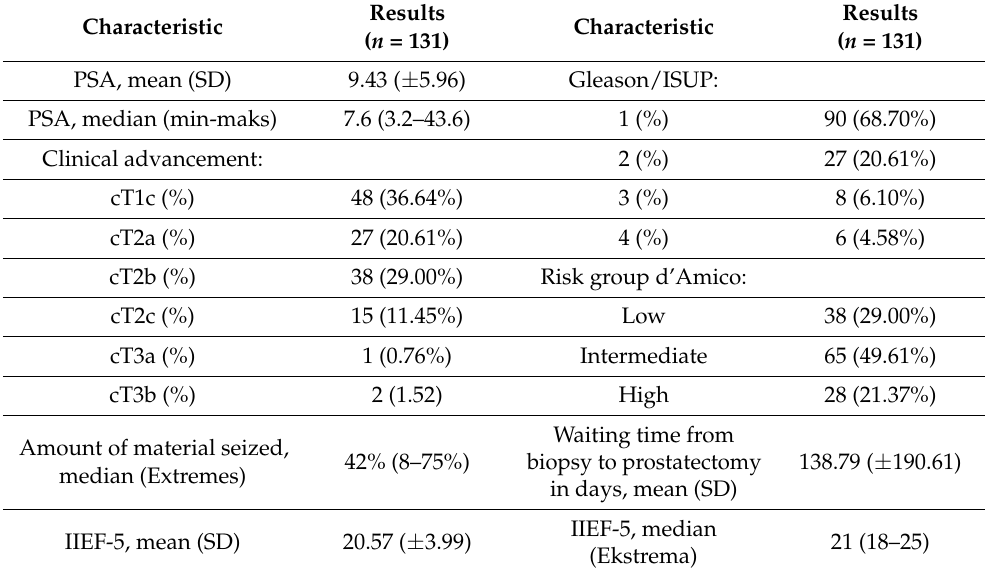
Table 2. Oncological and functional characteristics of the study